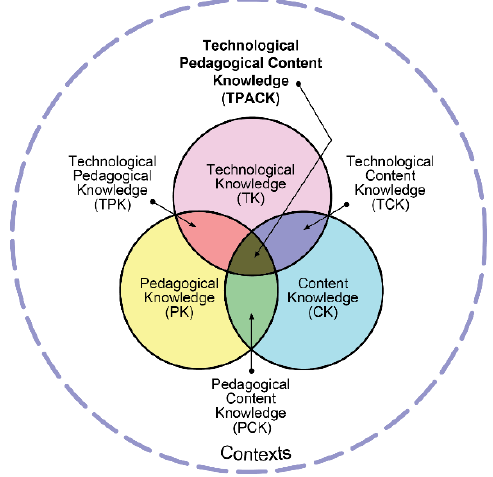
Fig. 1. TPACK model by Mishra and Koehler